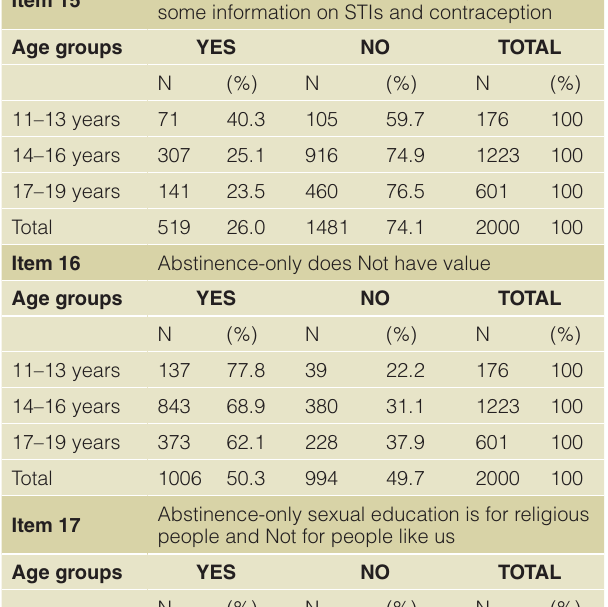
Table 4. Perspective of adolescents according to age group on the acceptance of abstinence-only sexual education. Item 15